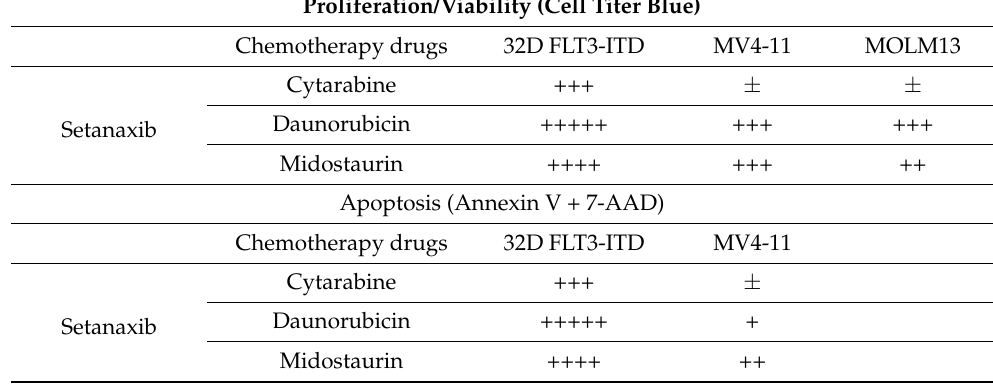
Table 1. Analysis of the potential synergy of the combined treatments of different AML cell lines with Setanaxib and with different cytotoxic drugs. 32D FLT3-ITD, MV4-11, or MOLM13 cells were subjected to drug treatments. Experimental conditions for cell treatments were as in Figure 2. Setanaxib was applied at 1, 3, 10 or 30 µ M, cytarabine at 100 or 500 nM, daunorubicin at 20 or 30 nM, and midostaurin at 10 or 20 nM. The proliferation/viability of the cells was assessed by Cell Titer Blue assay after 72 h of treatments. Apoptosis rates were measured by FACS analysis after 48 h of treatments. The CI values were calculated with the Chou method using the software Calcusyn. A CI of <1 indicates synergism (<0.1 very strong synergism (+++++), 0.1 to 0.3 strong synergism (++++), 0.3 to 0.7 synergism (+++), 0.7 to 0.85, moderate synergism (++), 0.85 to 0.90, low synergism (+), and 0.90 to 1.1, nearly additive ( ± ). Three independent experiments (in triplicate) were